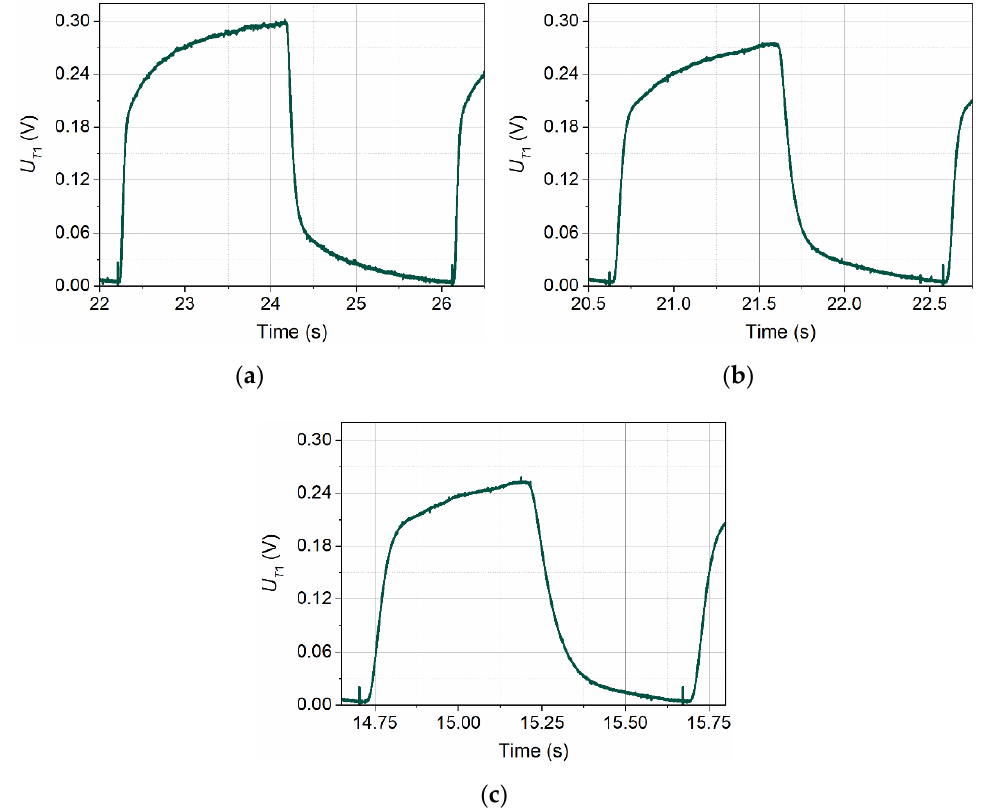
Figure 4. Pulse shapes recorded by detector T1 for three thermal wave frequencies: f = 0.25 Hz ( a ), f = 0.50 Hz ( b ), and f = 1.00 Hz ( c ), at the inflow velocity v ∞ = 0.065 m/s.